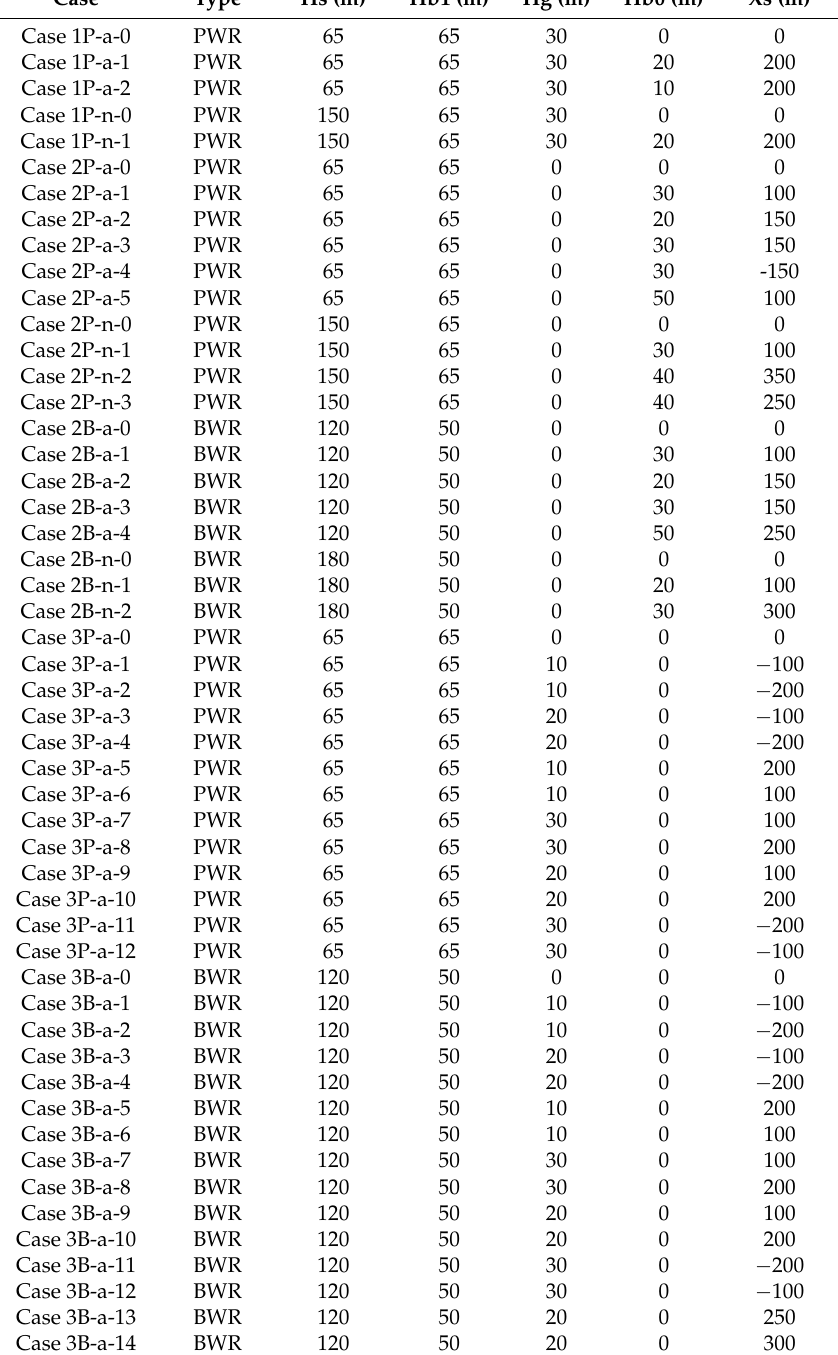
Table 1. Wind tunnel experimental